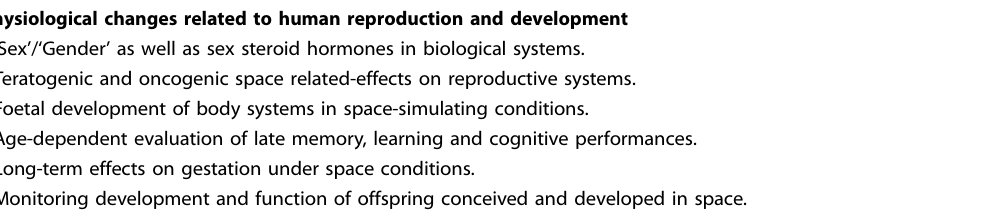
Table 1. Potential priorities for future space programmes as described in the white paper collection of ESA according to previously identi fi ed key knowledge gaps, with a focus on microgravity and/or exploration relevance a . Physiological changes related to human reproduction and